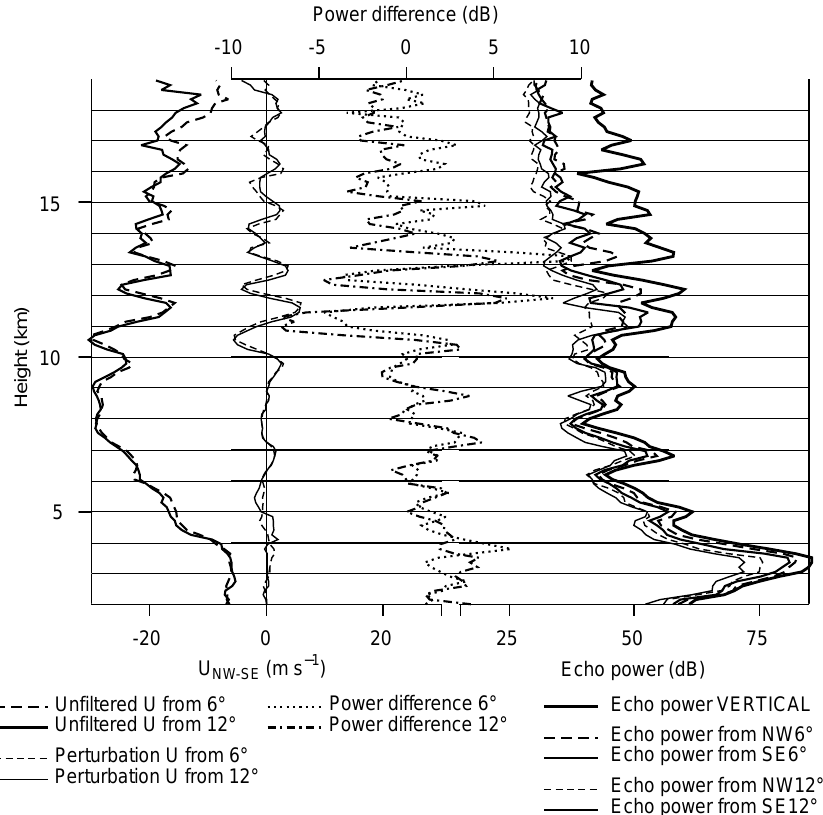
Fig. 4. Profiles of: wind velocity in the NW–SE direction (total, and filtered to remove the background wind and peri- ods less than 6 h); the unfiltered power di(cid:128)erences between NW6 (cid:14) and SE6 (cid:14) , and NW12 (cid:14) and SE12 (cid:14) beams; unfiltered echo powers for vertical, NW6 (cid:14) , SE6 (cid:14) , NW12 (cid:14) and SE12 (cid:14) beams. The data are averaged over 1 h, 1330–1430 GMT 14